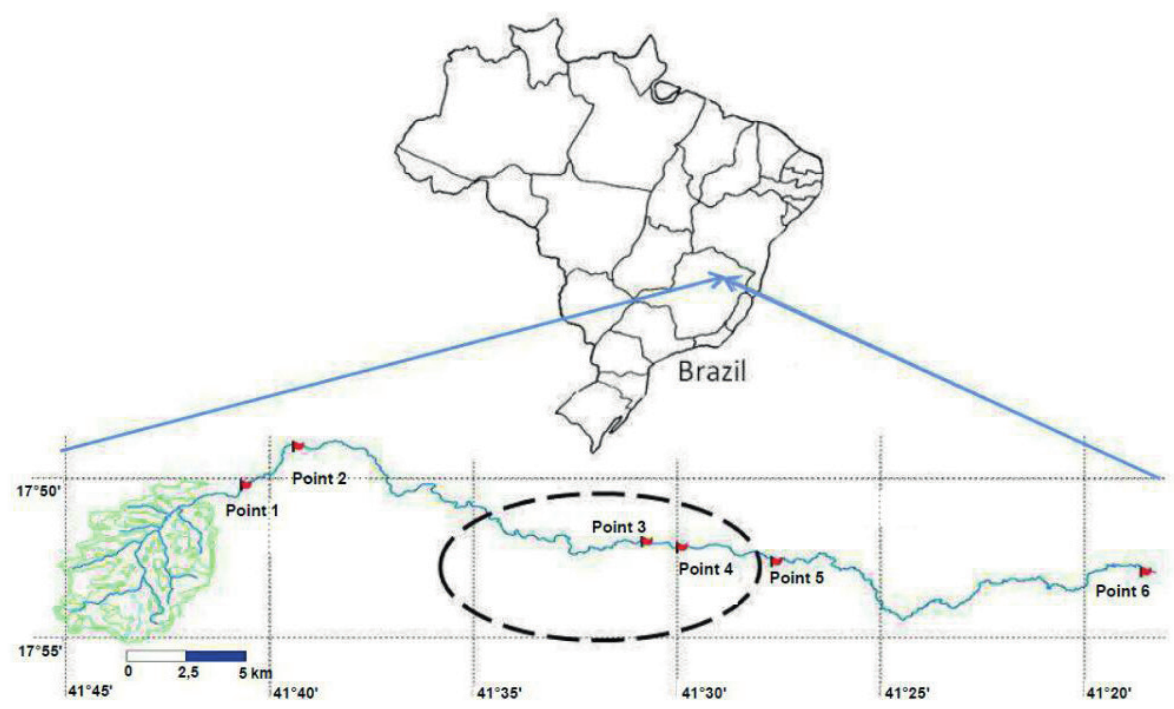
Figure 1 - Points of water samples collected from Todos os Santos River. Point 1 and Pont 2 are located upstream the urban area of Teófilo Otoni city and near the source of the river; points 3 and 4 are located within the urban area, and points 5 and are located downstream the urban